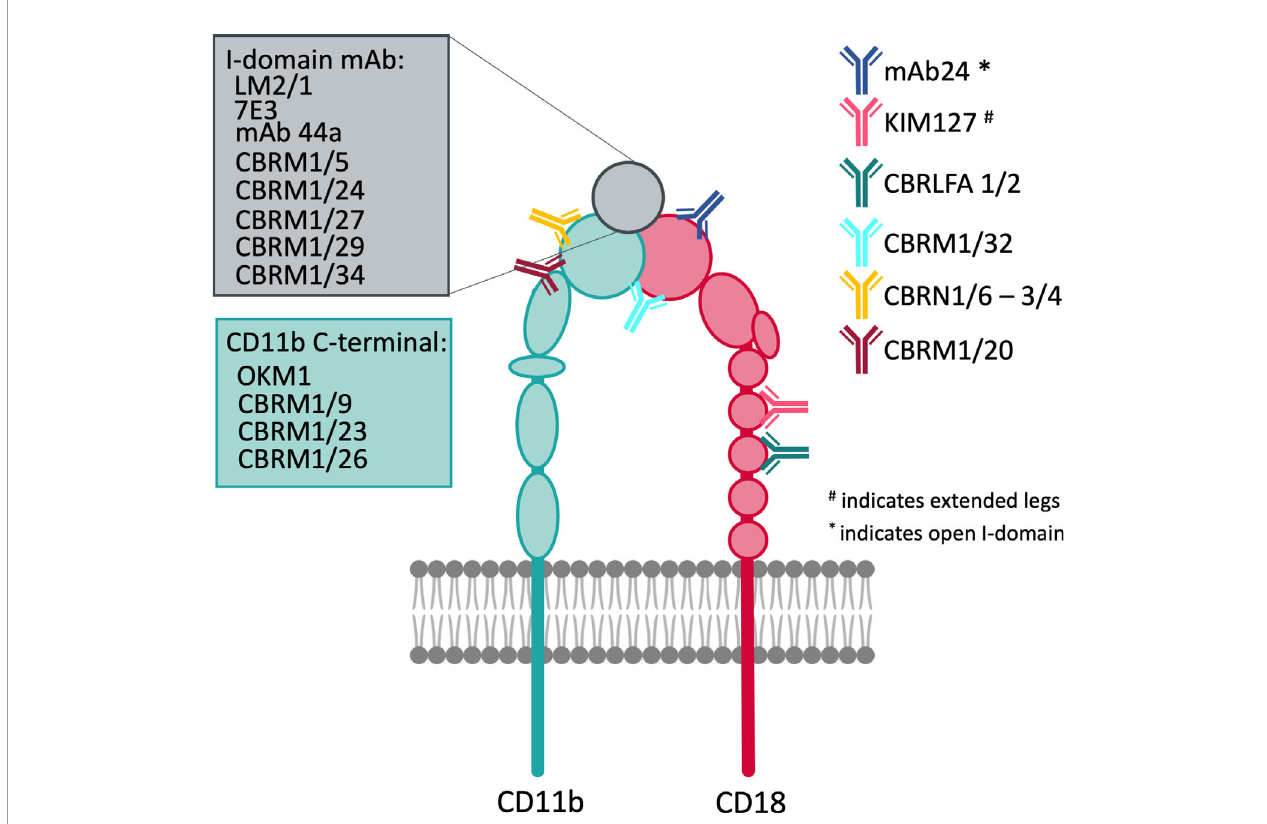
FIGURE 5 | Overview of important antibodies developed against CD11b and CD18 mapped to their reactive